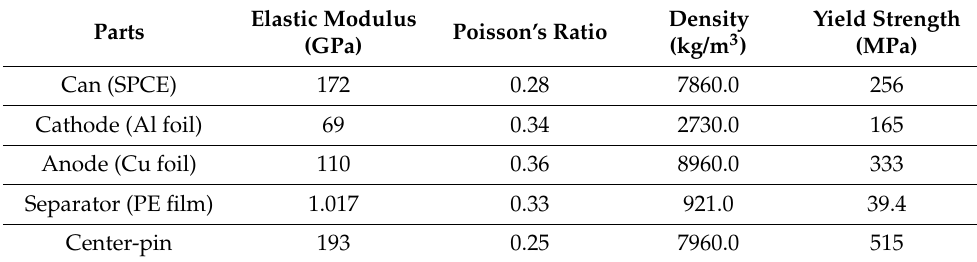
Table 1. Material properties of cell components.